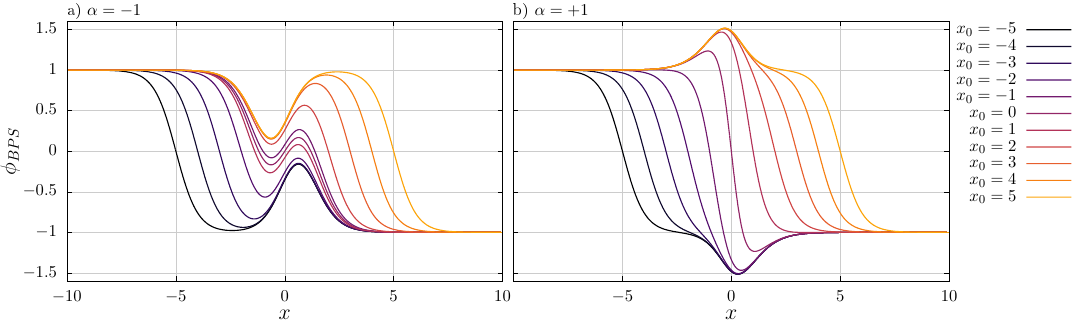
Figure 2 . Solutions of the Bogomolny equation for di(cid:11)erent positions of the topological zeros for (cid:11) = (cid:6)